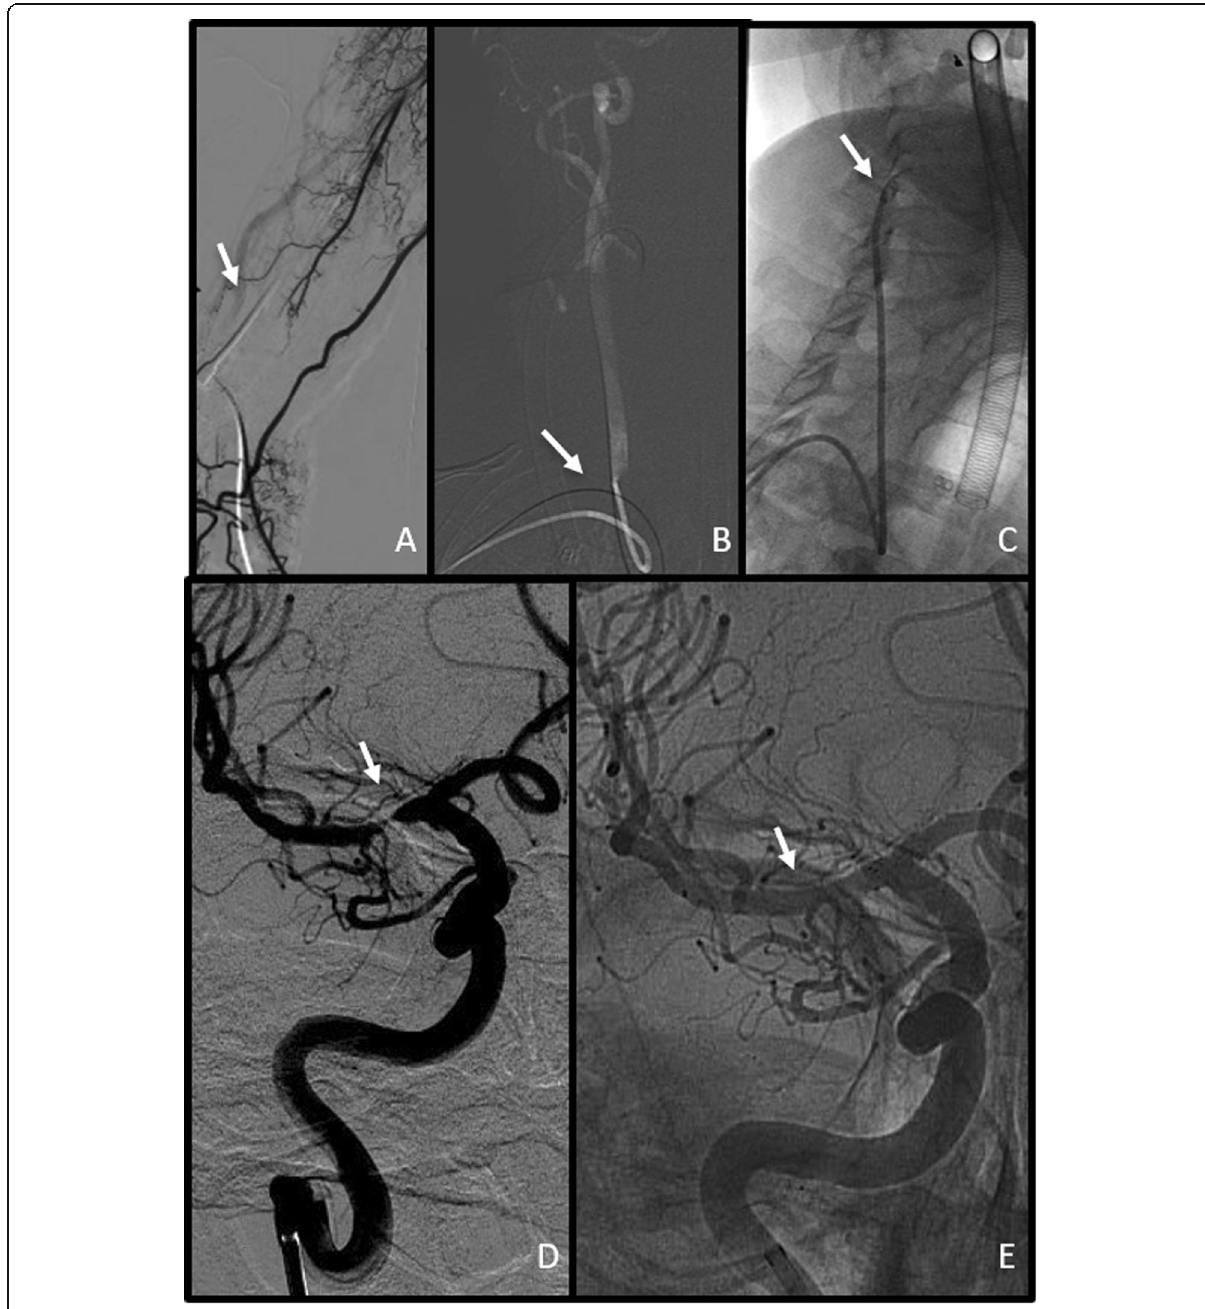
Fig. 6 Therapeutic DSA in a in a 72-year-old man with right intracranial atheromatous stenosis. After 6-F right TRA (arrow in a ), on exchange wire in right ECA (arrow in b ), a 95-cm Benchmark .071 was advanced into right ICA (arrow in c ) and right M1 MCA flow restoration was obtained after angioplasty and stenting (arrows in d and e